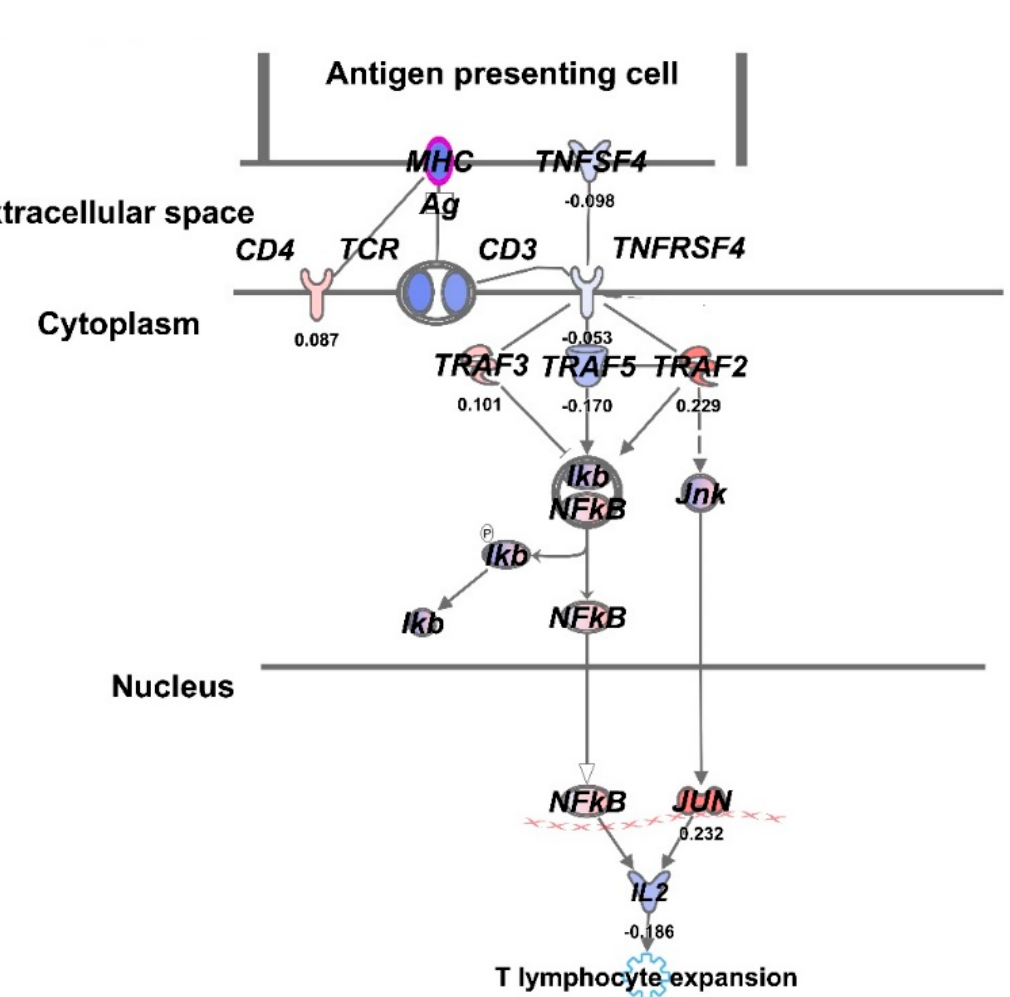
Figure 5. Identification of novel OX-40 check point signaling pathway in U-CH2 chordoma cells treated with end of Bragg peak proton radiation. Phosphorylation ( p ) of Ikb kinase tightly inhibits NFkB activation and its downstream adverse effects.